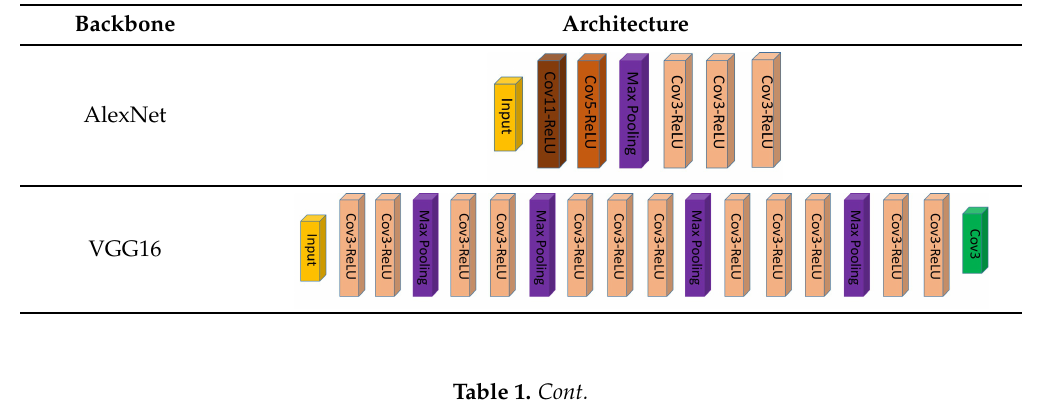
Table 1. The architecture of four backbones: AlexNet, VGG16, ResNet18, MobileNet V2.